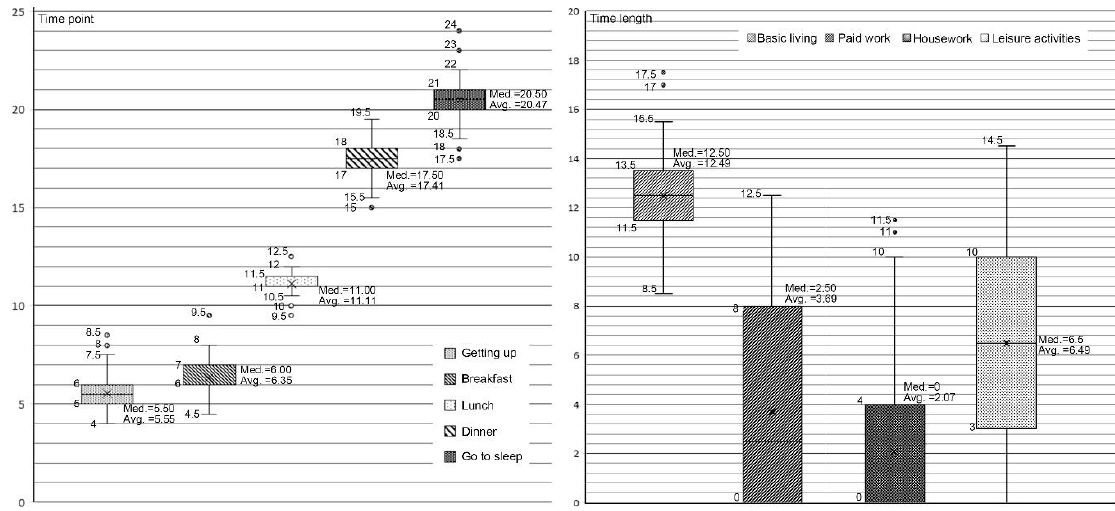
Figure 2. Temporal characteristics of daily activities of older adults in rural areas.